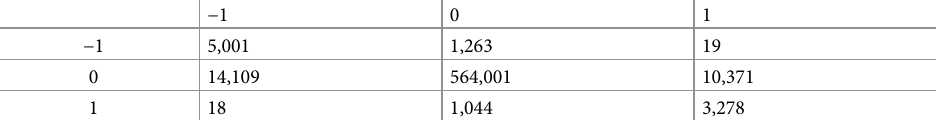
Table 6. Comparison of signed phenotype hits for the MV model applied to the most KL-divergent subsampled data set of training size N = 500 (left) compared to the full data set of training size N = 2000 (top). We represent calls by a number in { − 1,0,1}, with 1 and − 1 denoting significant positive and negative phenotypic perturbations, respectively, and 0 denoting a lack of statistical significance. − 1